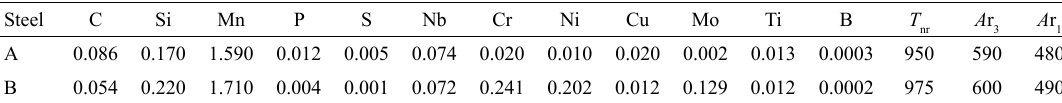
Table 1. Chemical composition (wt %) and measured transformation temperature (ºC) of both steels.